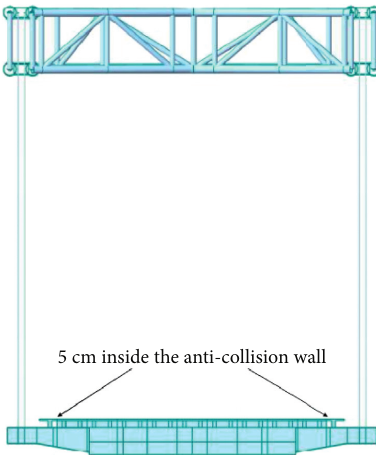
Figure 13: Front-view of the layout of alignment measurement points of the bridge